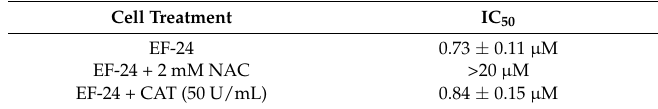
Table 1. Effect of N -acetylcysteine (NAC) and catalase (CAT) on cell proliferation and viability in EF-24-treated K562